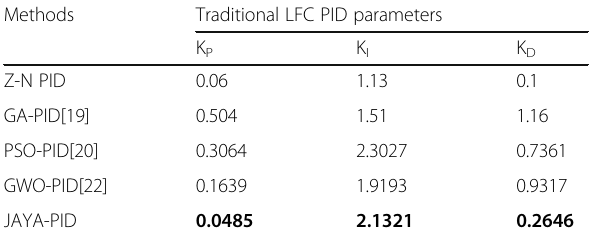
Table 2 Optimized PID parameters with different approaches